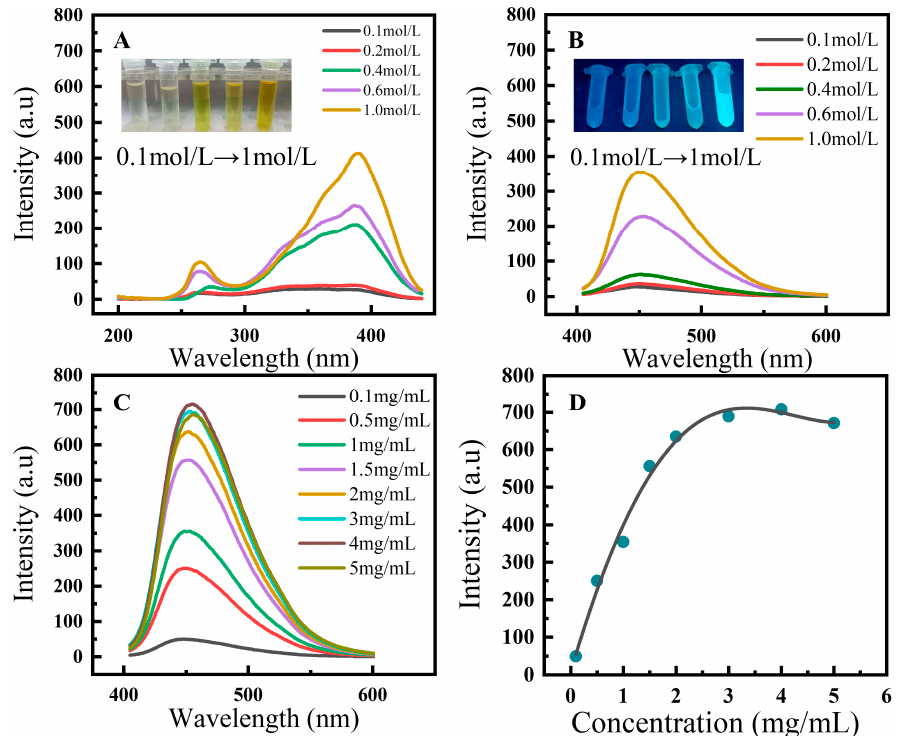
Figure 3. ( A ) Fluorescence excitation and ( B ) emission ( λ EX = 390 nm) spectra at various concen- trations of 2.0G PAMAM. ( C ) Emission ( λ EX = 390 nm) spectra at various concentrations of 2.0G PAMAM-DCM PDs solutions. ( D ) Curve-fitting for the fluorescence intensity and 2.0G PAMAM- DCM PDs concentration. Y = 479.96X − 87.82X 2 − 0.939X 3 + 0.92X 4 + 7.38, R 2 = 0.991; where Y is fluorescence intensity, X is the concentration. Inset in ( A , B ) are photographs of 2.0G PAMAM- DCM PDs with different concentrations, from left to right, taken under sunlight and UV light ( λ EX = 365 nm),